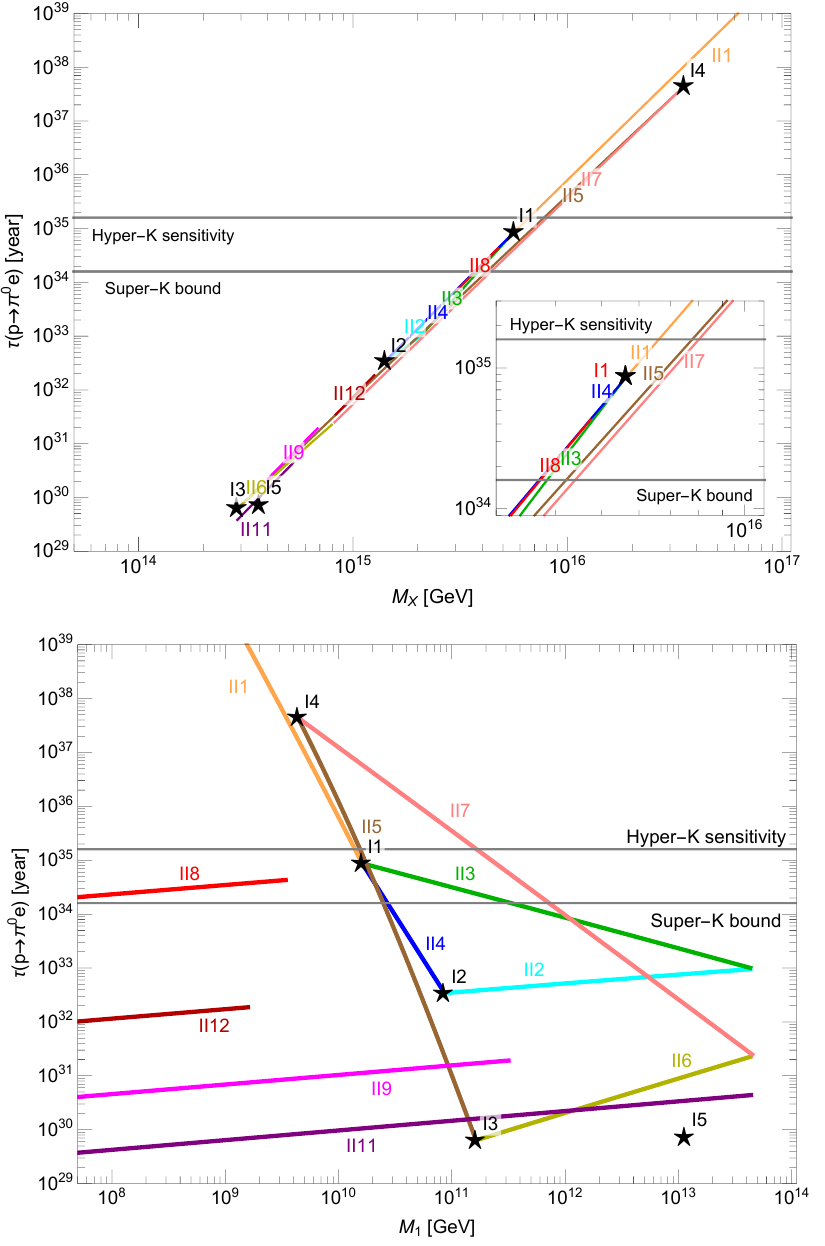
Figure 4 . Predictions of the proton decay lifetime as a function of the GUT scale, M X , and intermediate scale, M , in breaking chains cI1-5 and cII1-12. The colour for each chain is specified 1 in both the upper and low panel. Labels for each chains in the upper panel are not shown as regions for these chains overlap